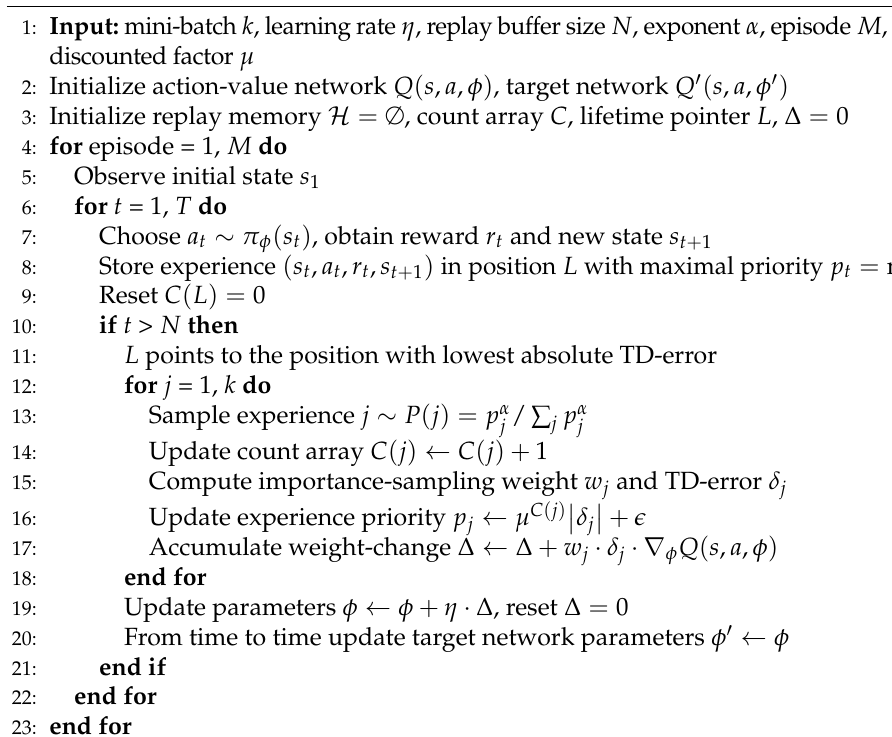
Algorithm 1 Dueling DQN with